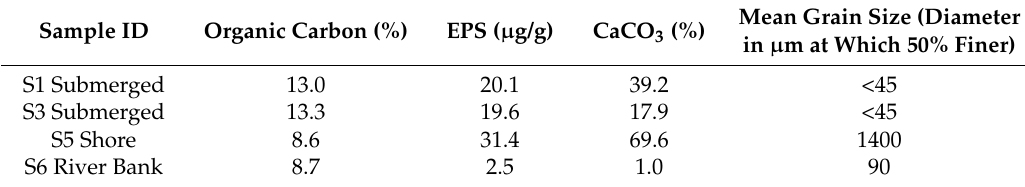
Table 1. Characteristics of Sediments from Guánica